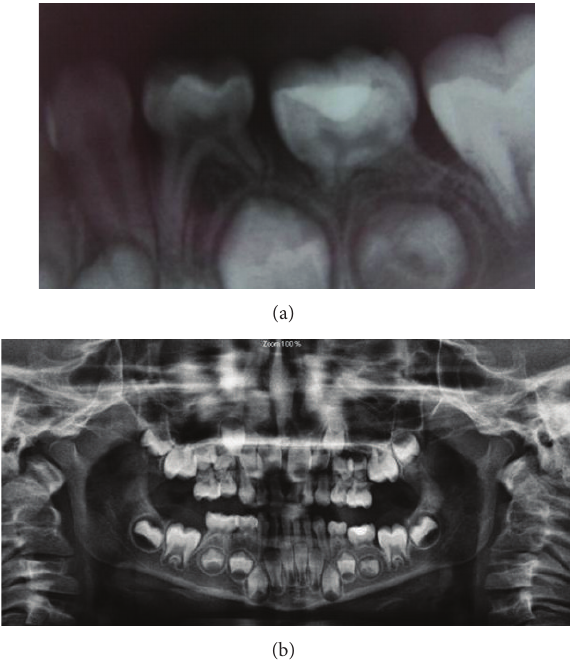
Figure 6: (a) Ten-month periapical view. (b) Ten-month panoramic